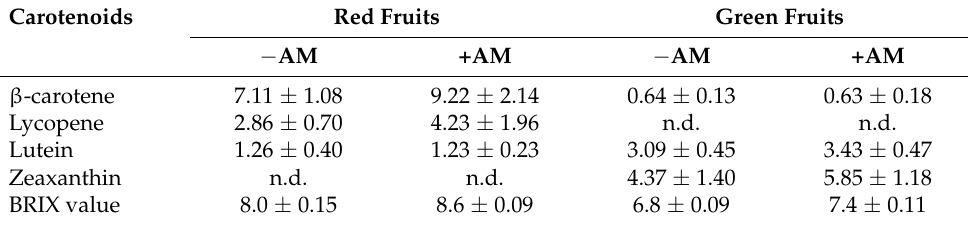
Table 2. Carotenoid contents of green and red fruits with and without mycorrhizal inoculation. Carotenoids Red Fruits Green Fruits − AM +AM − AM